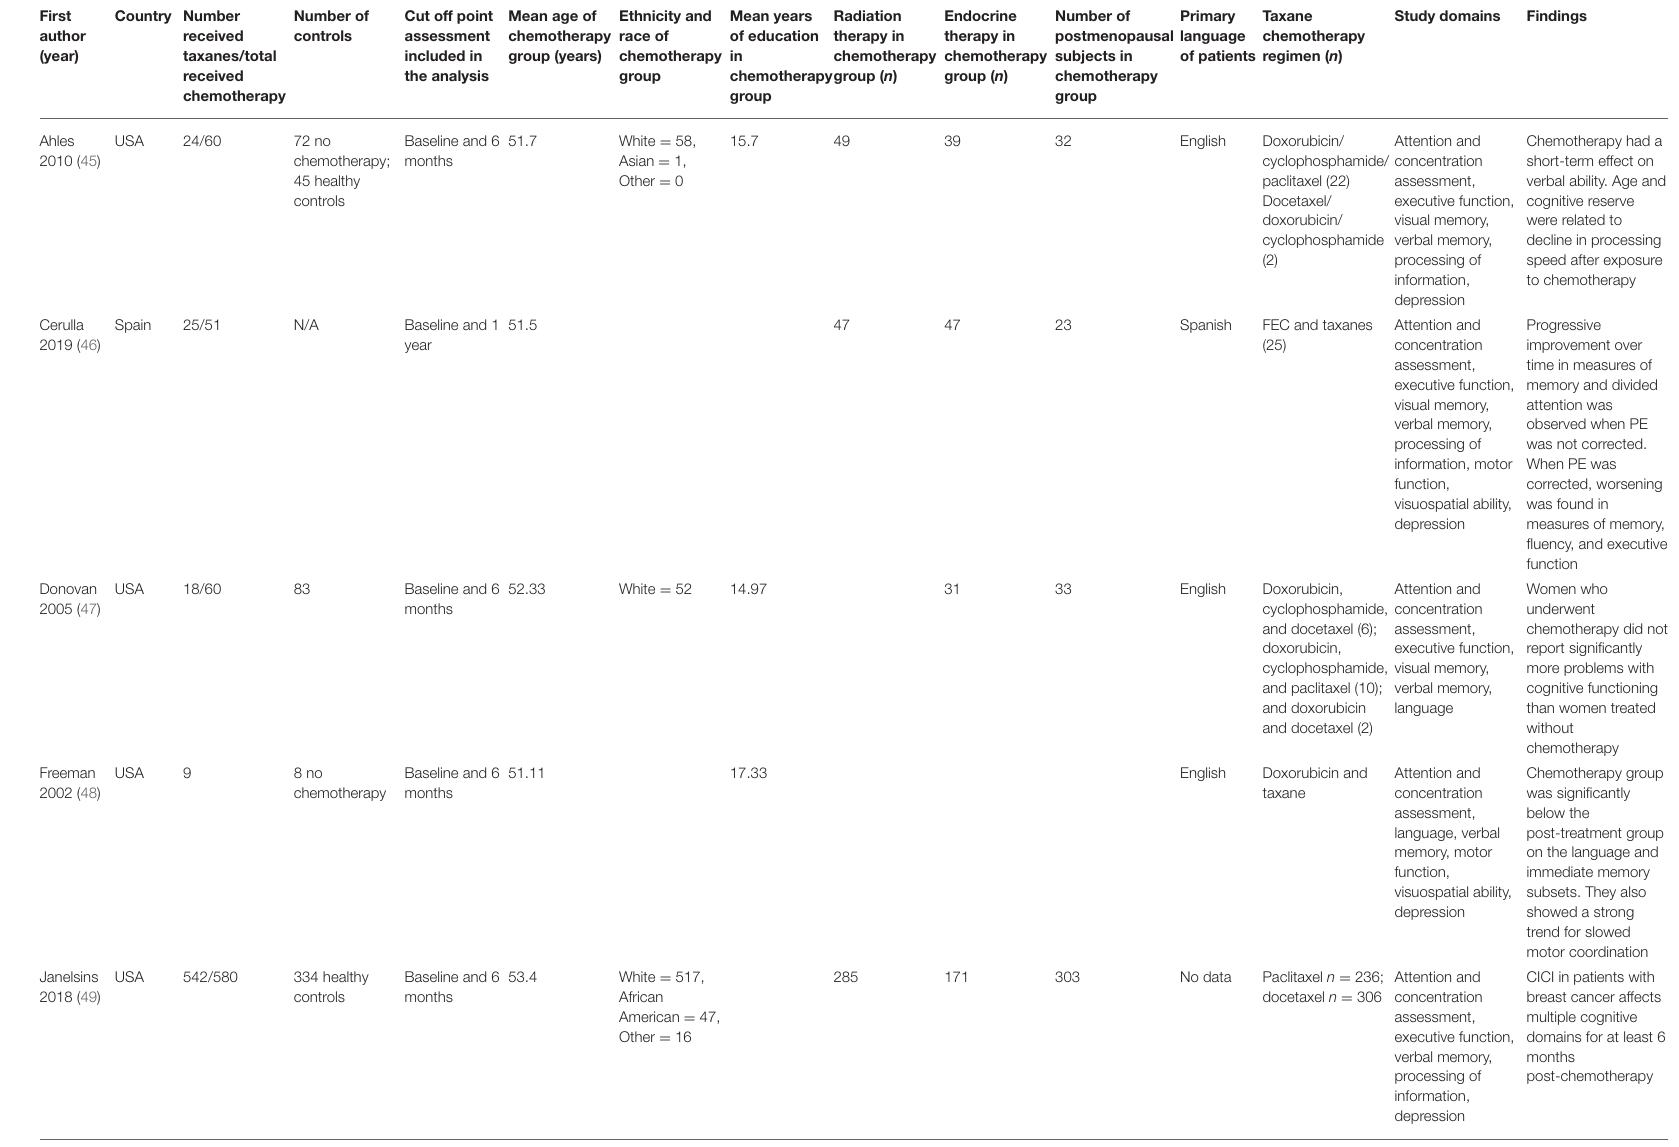
TABLE 1 | Characteristics of included studies ( k =